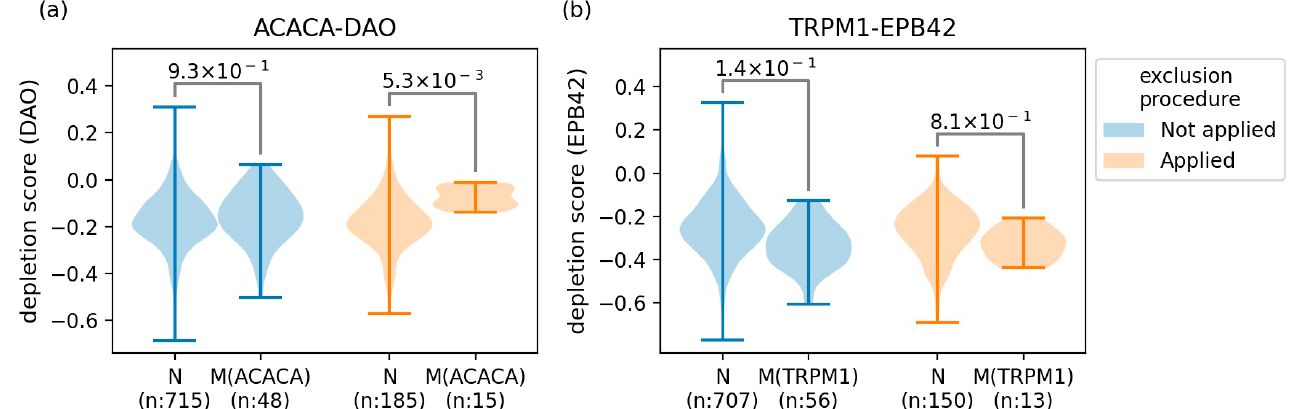
Figure 2. Violin plots of the depletion scores for the GIs whose significance was largely inconsistent according to the use of the exclusion procedure. Depletion scores of the knocked-out gene for normal and mutated cells were violin-plotted for the case where the exclusion procedure was applied or not. ( a ) The resistant GI between mutated ACACA and DAO was characterized only when the exclusion procedure was applied. ( b ) The sensitive GI between mutated TRPM1 and EPB42 was characterized only without the exclusion procedure. The numbers assigned to a pair of violin plots indicate FDRs of t -tests. N: normal cells (cells not harboring the mutation), M: mutated cells (cells harboring the mutation), n; number of depletion scores.